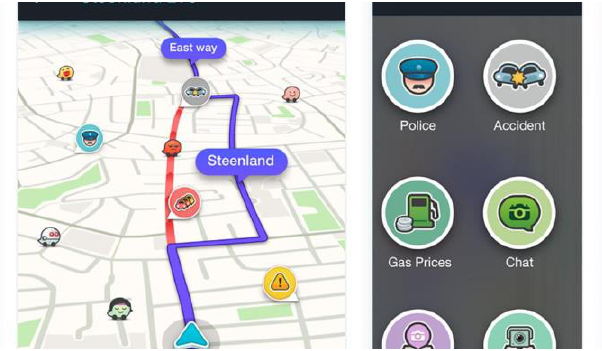
Figure 4. Presentation of alternative route suggestions and notification (active data entry) screen depending on the traffic density in the Waze